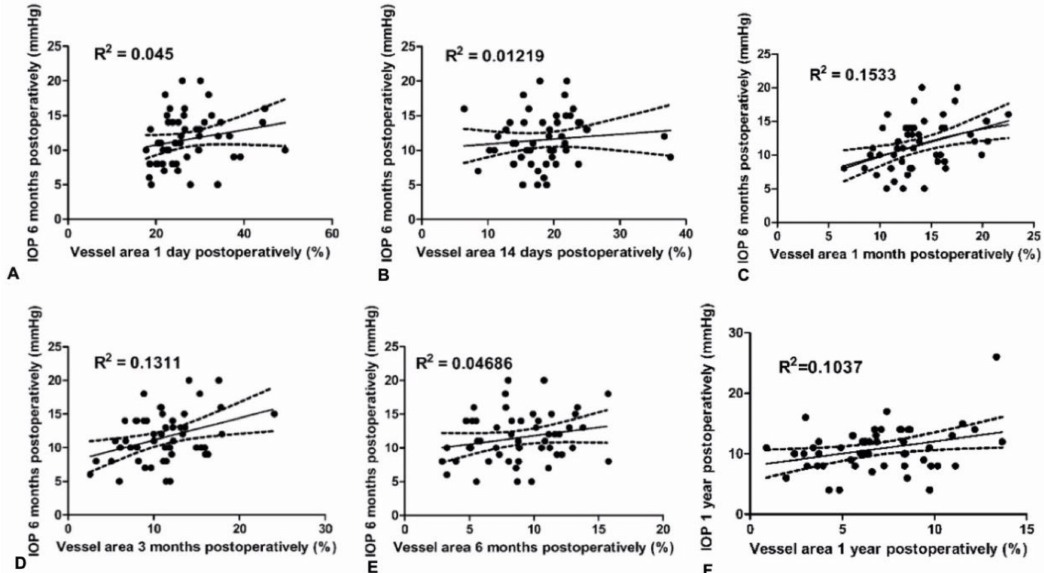
Figure 3. Scatterplots showing correlations between bleb vascularity (%) in early postoperative period and IOP 6 and 12 months after trabeculectomy. ( A , B , E ) There was no significant correlation between vascularity of the filtering bleb at day 1, 14 or 180 and IOP 6 months after trabeculectomy. ( C , D ) There was significant positive correlation between the vascularity of the filtering bleb 1 month postoperatively and IOP 6 months after surgery ( R 2 = 0.1533, p = 0.005) and 3 months postoperatively and IOP 6 months after surgery ( R 2 = 0.1311, p = 0.009). ( F ) There was significant positive correlation between bleb vascularity at 1 year and IOP 1 year after trabeculectomy ( R 2 = 0.1037, p =